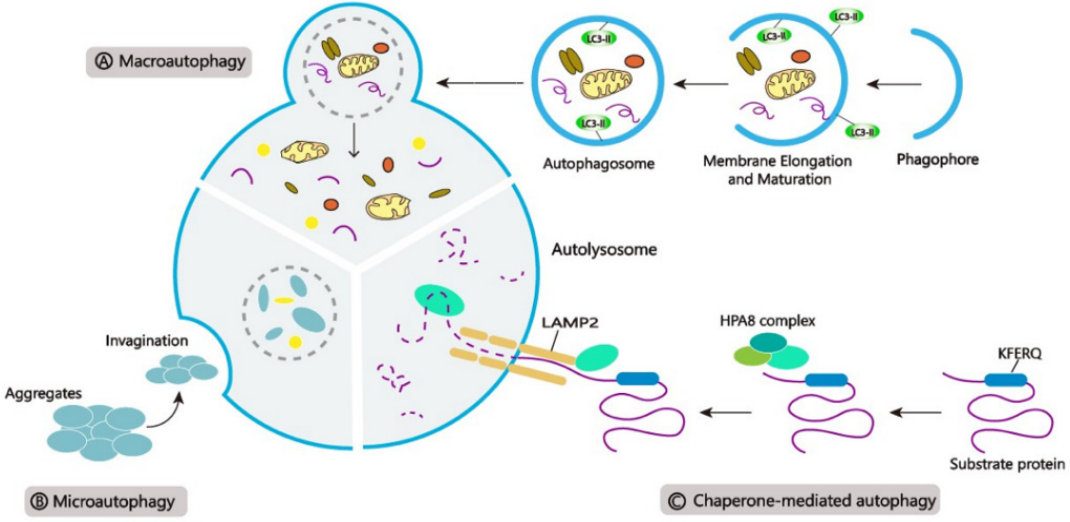
Figure 1. Three main types of autophagy. ( A ) Macroautophagy, ( B ) Microautophagy, and ( C ) Chaperone-mediated autophagy (CMA).